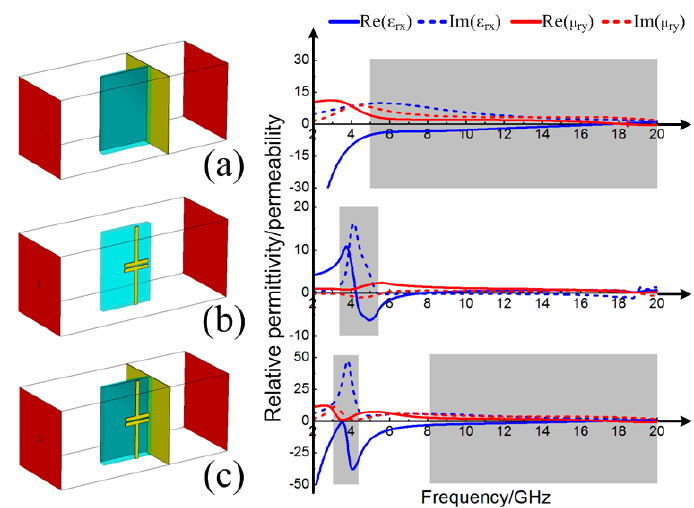
Figure 6. Constitutive parameters of: ( a ) the three-dimensional resistive MA; ( b ) the metallic bamboo joint on the substrate; and ( c ) the three-dimensional resistive MA loaded with the metallic bamboo joint.